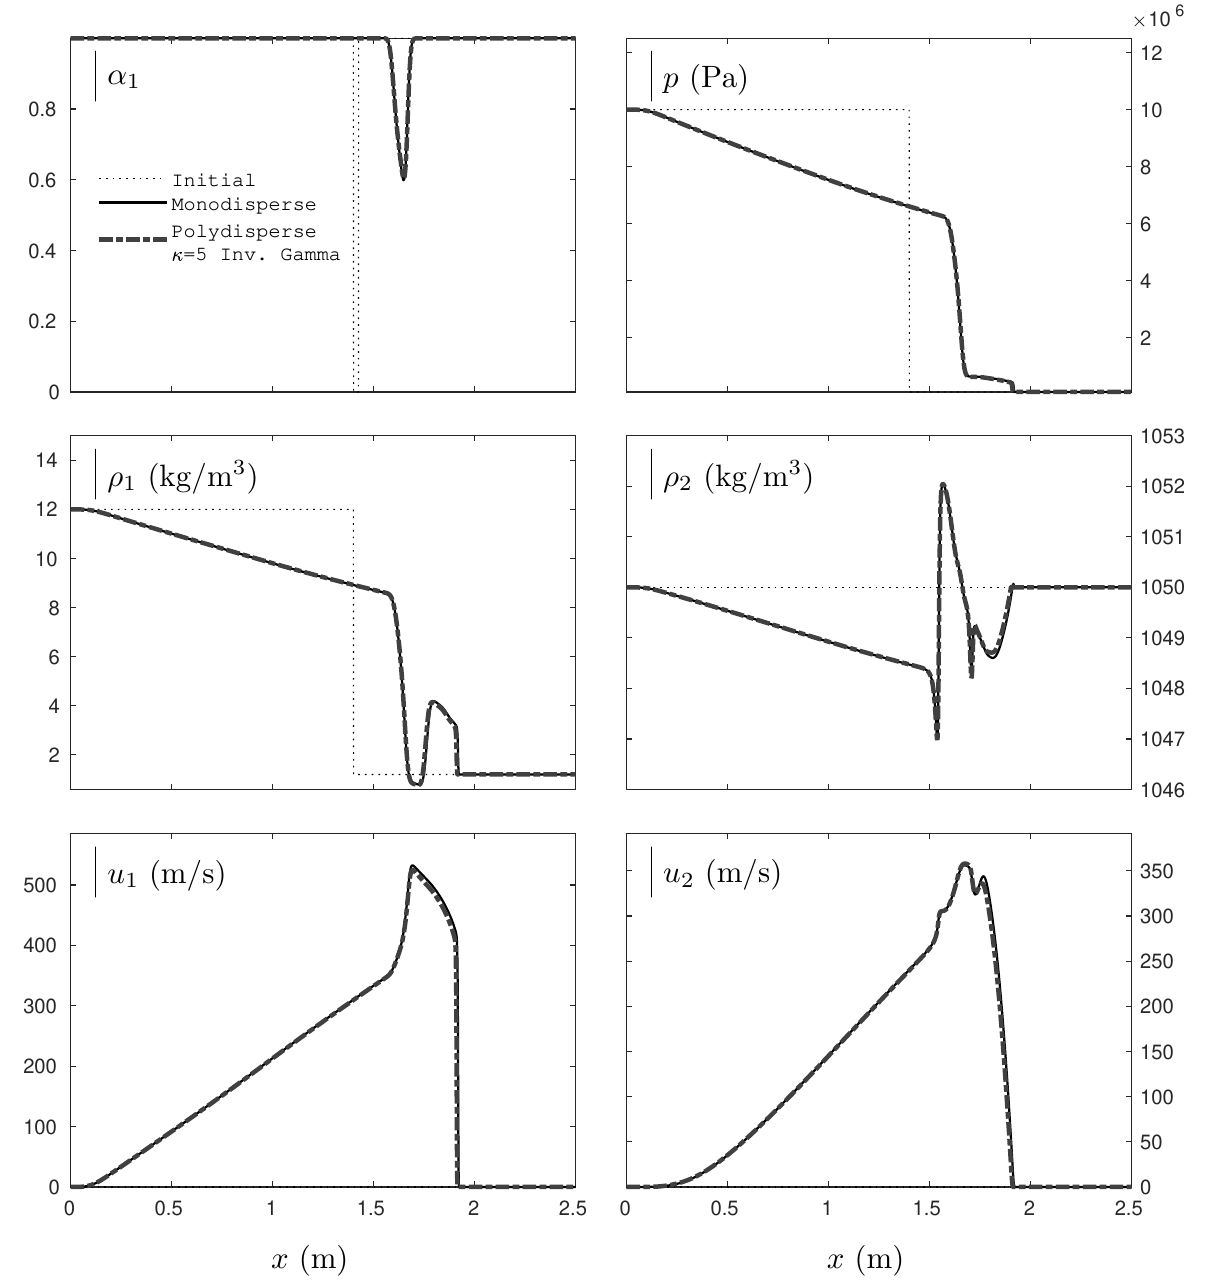
Figure 10: Simplified two-phase explosion test depicted in Fig. 5. Figure 10. Simplified two-phase explosion test depicted in Figure 5. Comparison of the monodisperse and polydisperse results. The initial specific interfacial area is the same for both computations monosdisperse radius of R t =0 = A t = 0 A t = 0 and is computed via an initial monodisperse radius of R t = 0 2 I ,mono. I ,poly. polydisperse computation, the Inverse Gamma distribution is used with κ = 5. All results are given at time t = 1.2 ms and are presented in terms of α 1 , p , ρ 1 , ρ 2 , u 1 and u 2 for both computations. The two computed solutions are very close, only slight differences appear in the various